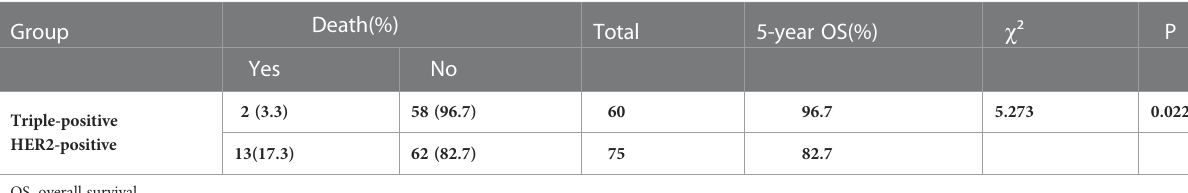
TABLE 3 Survival of triple-positive breast cancer and HER2-positive breast cancer. Group